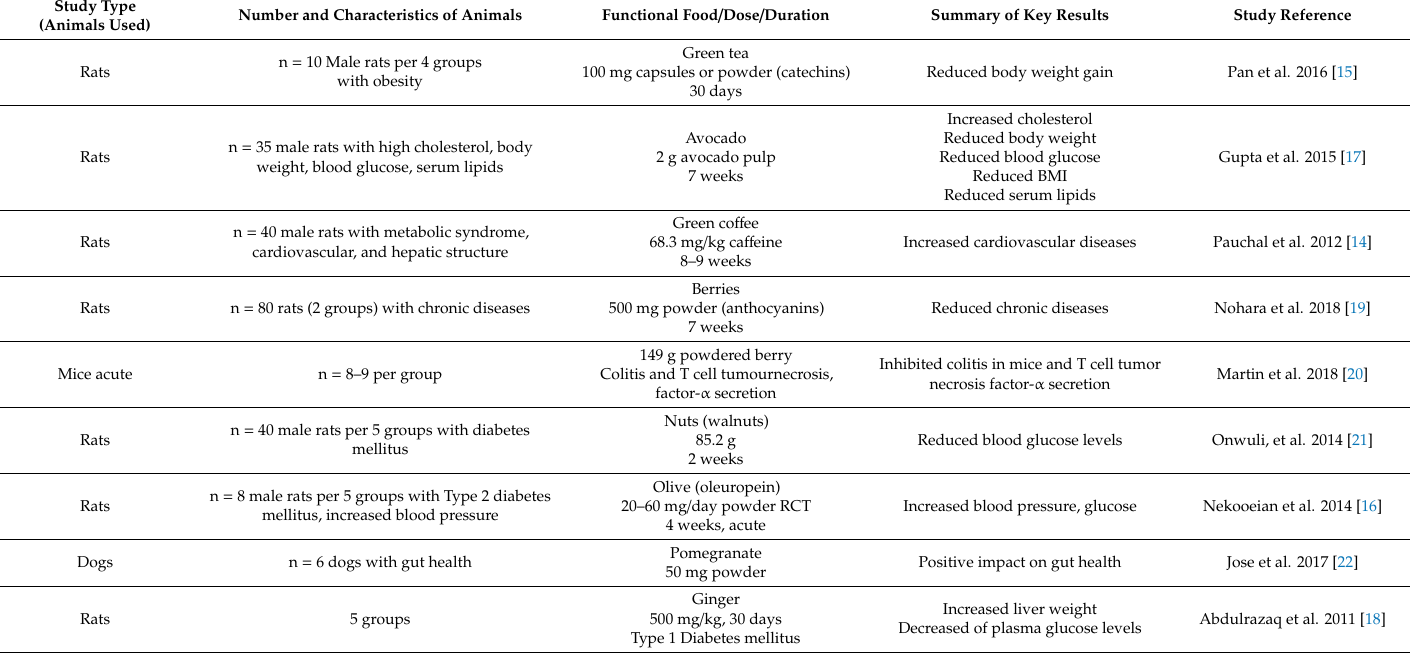
Table 1. Animal studies about the possible e ff ect of functional foods and bioactive compounds on body weight control, obesity, and its metabolic